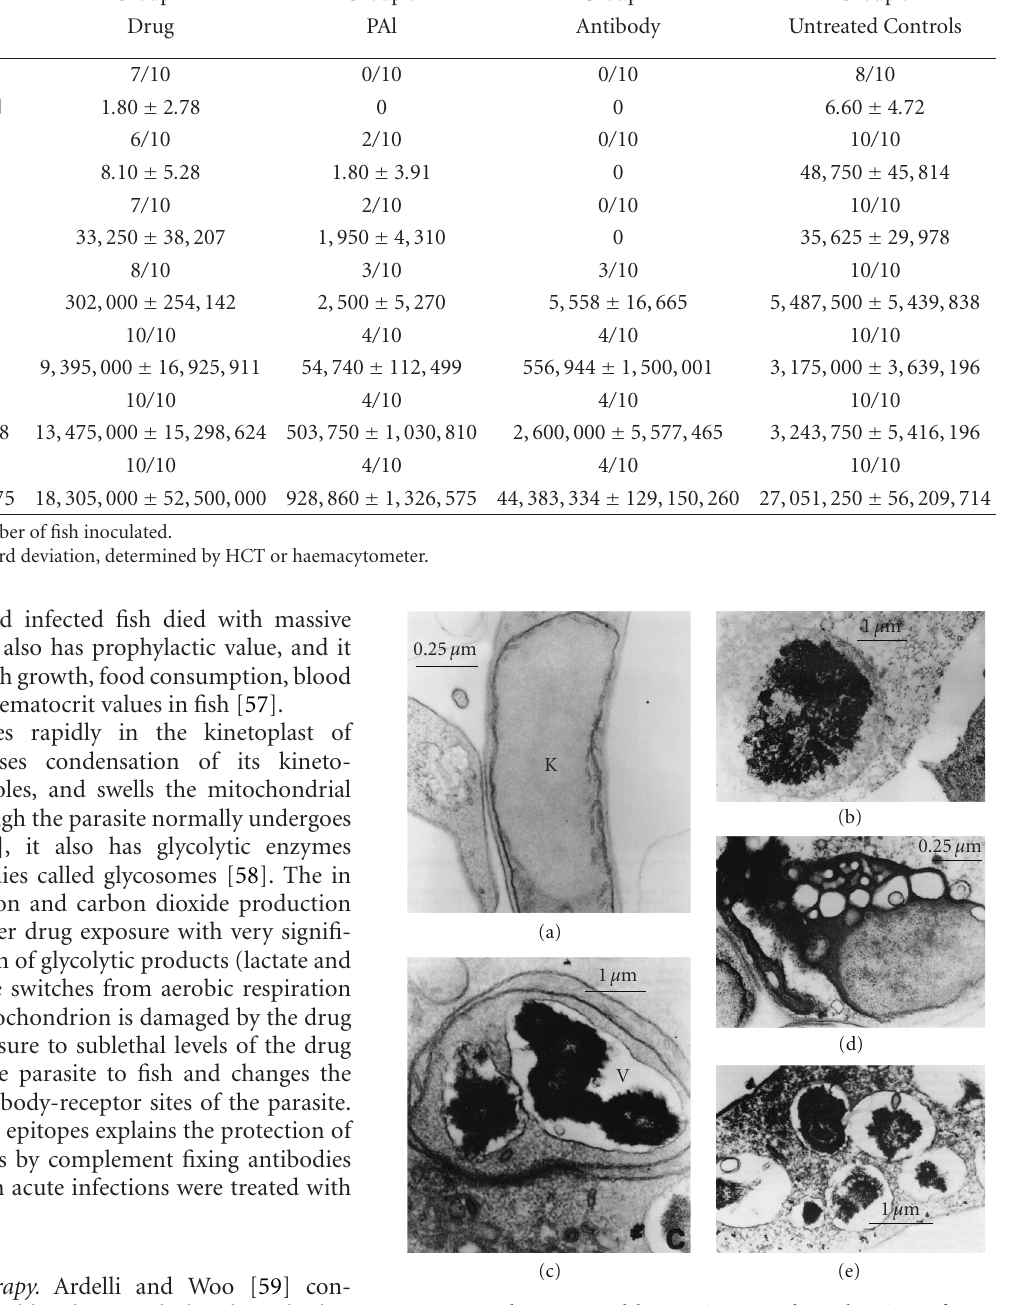
Figure 8: Ultrastructural lesions in Cryptobia salmositica after in vitro exposure to isometamidium chloride. (a) Parasite kinetoplast (K) not exposed to the drug; (b) condensation of kinetoplast DNA after exposure to the drug; (c) vacuole (V) formation after drug exposure; (d) swelling of mitochondrial cristae (C) after drug exposure; (e) vacuole formation in cytoplasm after drug exposure (reproduced from Ardelli and Woo